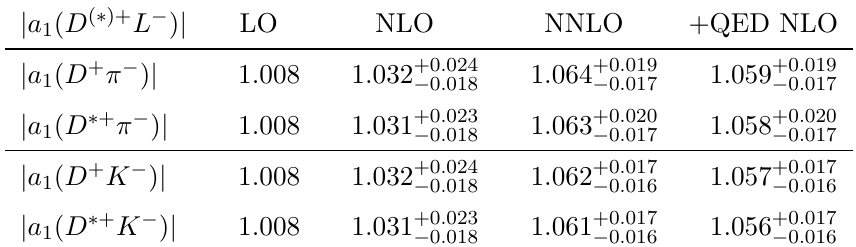
Table 2 . Results for | a 1 ( DL ) | at LO, NLO and NNLO using [4] for the NNLO expressions with inputs from table 1. In the last column, we added the QED NLO corrections δa K